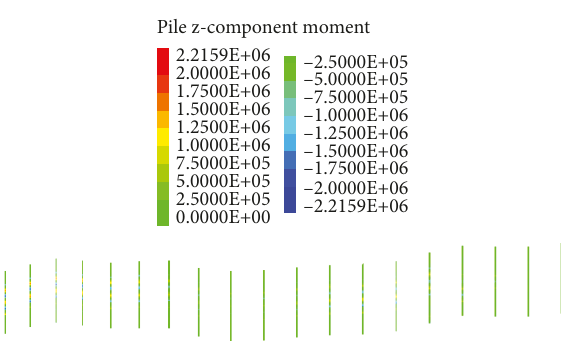
Figure 26: Pile bending moment distribution under polyline layout.